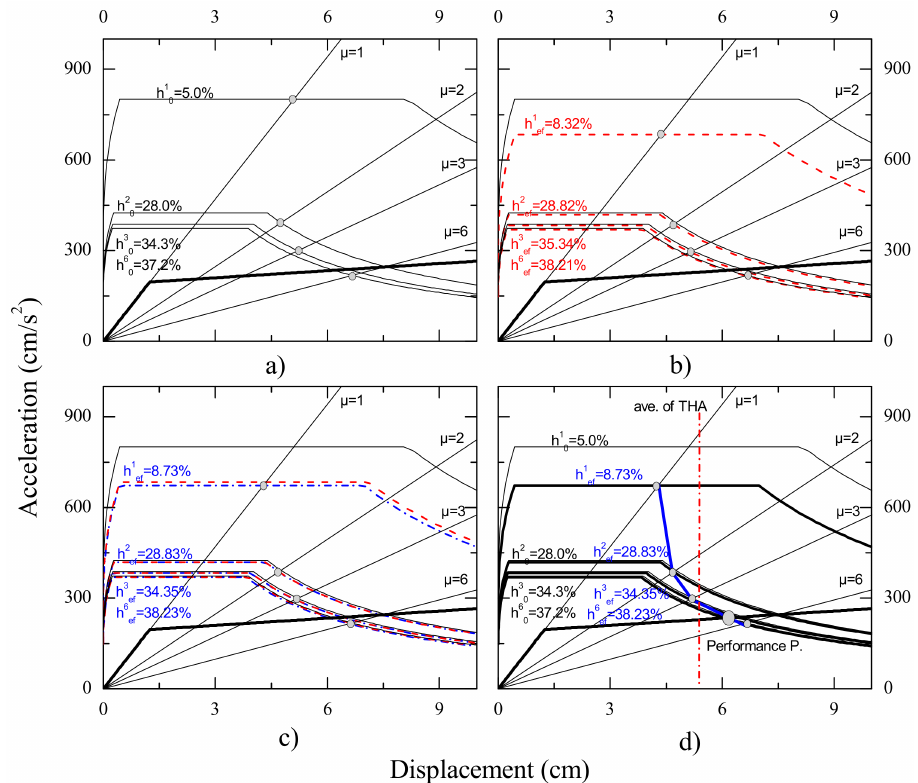
Figure 4. ( a – d ) steps of the proposed capacity spectrum method (CSM) applied to the ESDOF system using the damping-adjusted design spectra of a Level-2